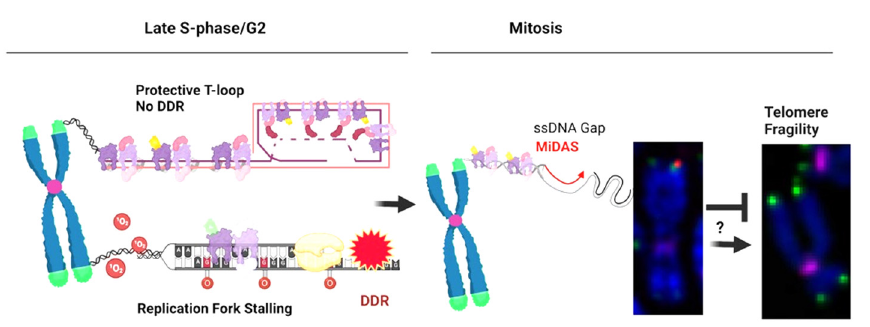
Figure 3. Speculative Model of the Relationship between Telomere Fragility and MiDAS . A normal chromatid end is folded into the protective T-loop structure by shelterin, which prevents DDR and chromosome fusions. When a replication fork stalls, by 8-oxo-guanine for example, this triggers a DDR. If replication is not completed by the end of G2, the under-replicated gap will persist when the cell enters mitosis. In order to fill the gap and maintain genome stability, cells can conduct telomere MiDAS in prophase. If MiDAS fails or is incomplete, under-replicated gaps will likely lead to mitotic segregation errors in the cell. When arrested in metaphase, however, this altered telomere structure can be observed with FISH, resulting in doublets or smeared signals. Created in BioRender.